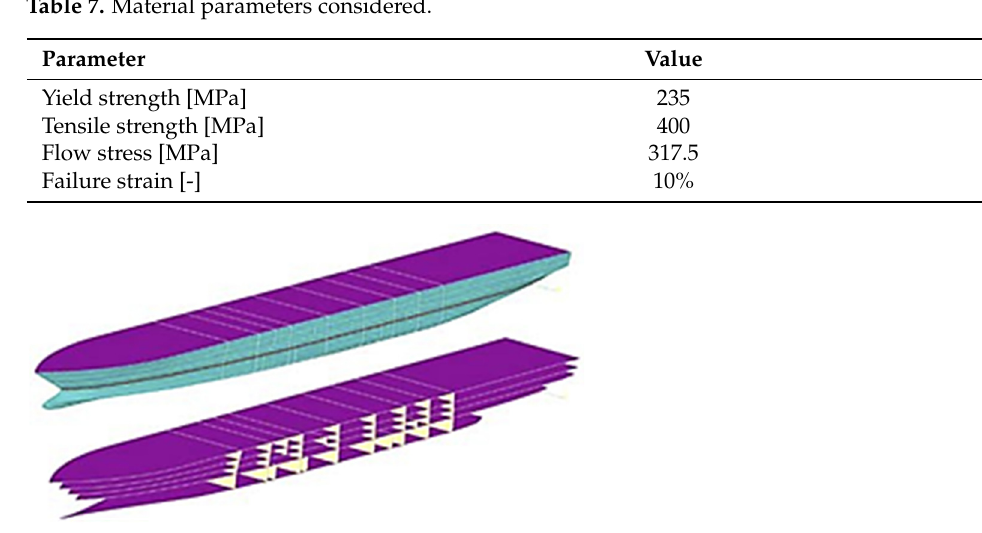
Figure 19. Struck ship SHARP model .